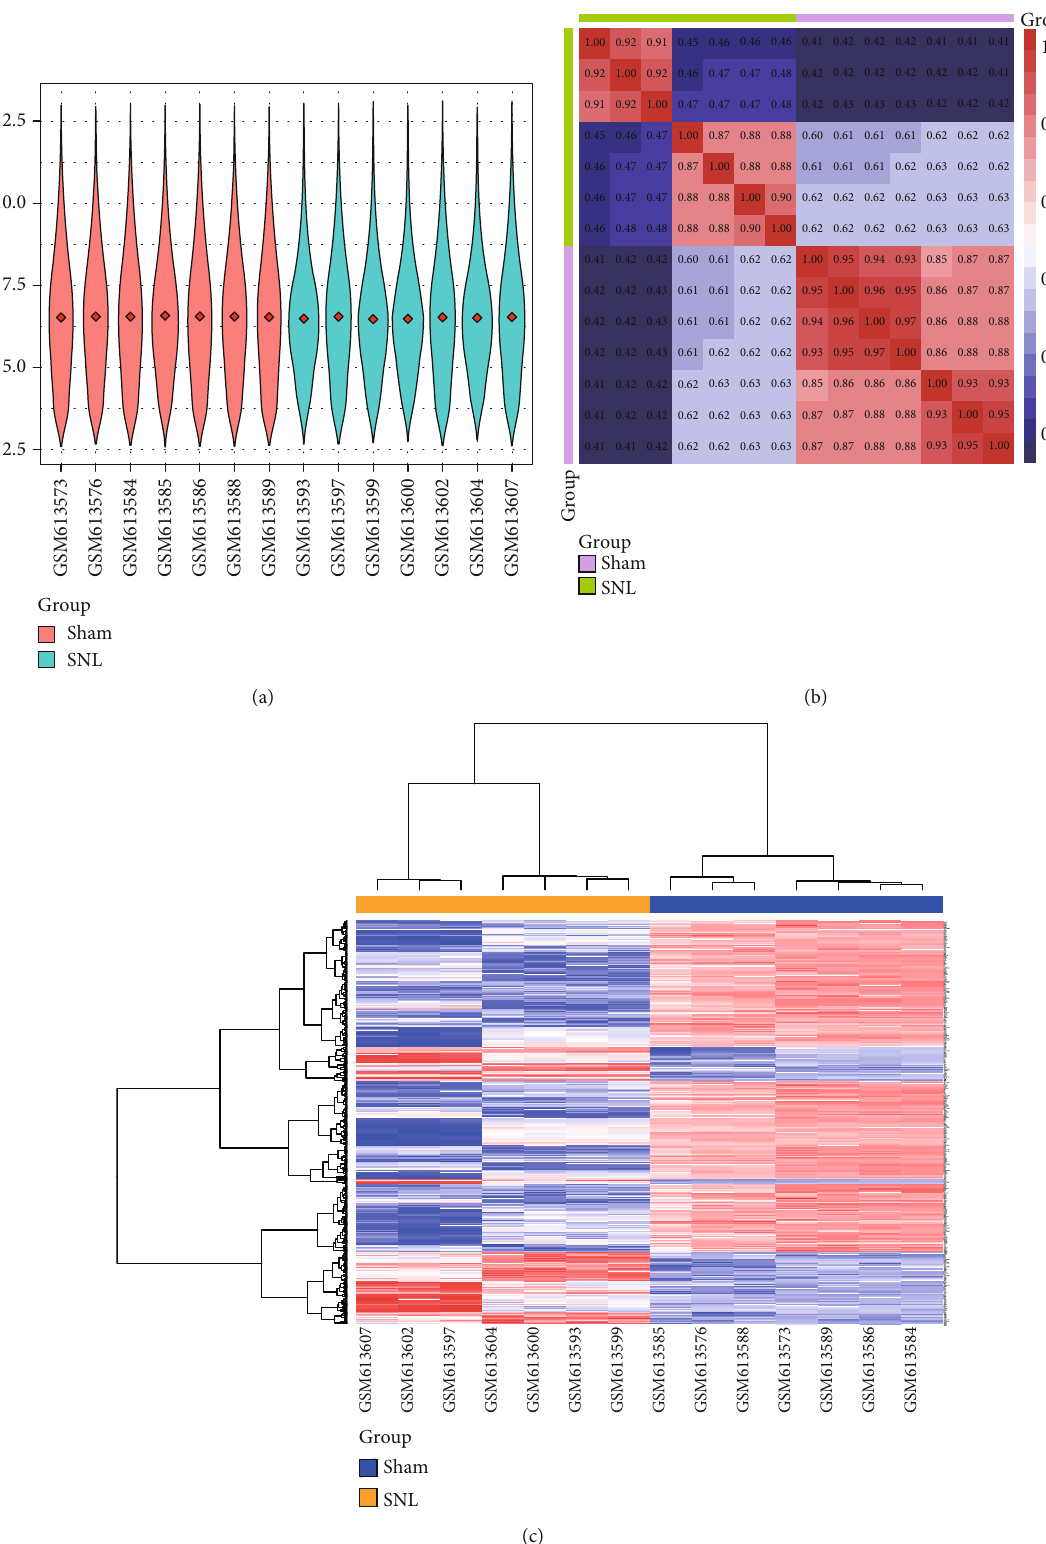
Figure 1: Data preprocessing and di ff erential gene expression analysis. (a) Violin map of the GSE24982 standardized expression data. The red diamond in each sample represents the average gene expression level. (b) Sample correlation heat map of the GSE24982 dataset. Red and blue indicate a strong and weak intersample correlation, respectively. (c) Heat map of the DEGs. Red indicates upregulation; blue represents